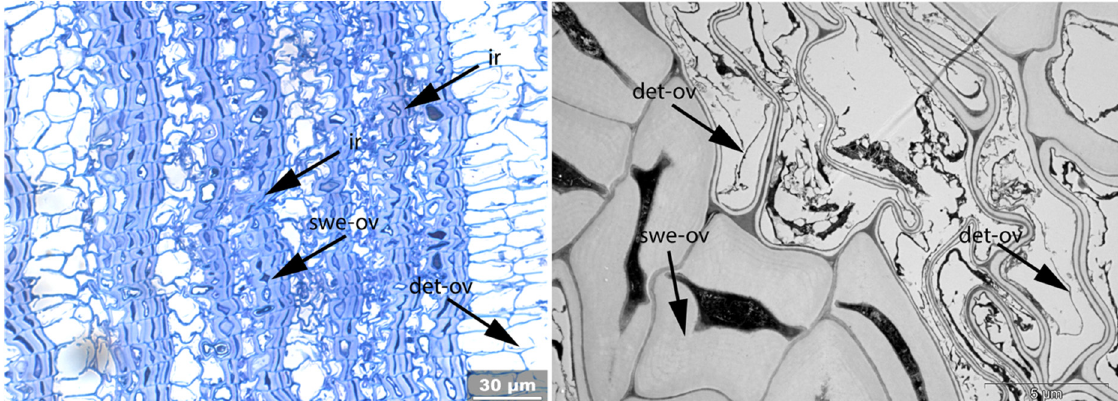
Figure 19. Sample 3. Left: LM image. Secondary cell walls of thick-walled cells are swollen (swe-ov). Deformation of cells has also taken place, leading to irregular structure (ir). Parts of tertiary cell wall of thin-walled cells are detached (det). Right: TEM image. Swelling of secondary cell wall of thick-walled cells is visible, together with detachment of parts of tertiary cell wall of thin-walled cells. In sample 3, this phenomenon is widespread and not localised.